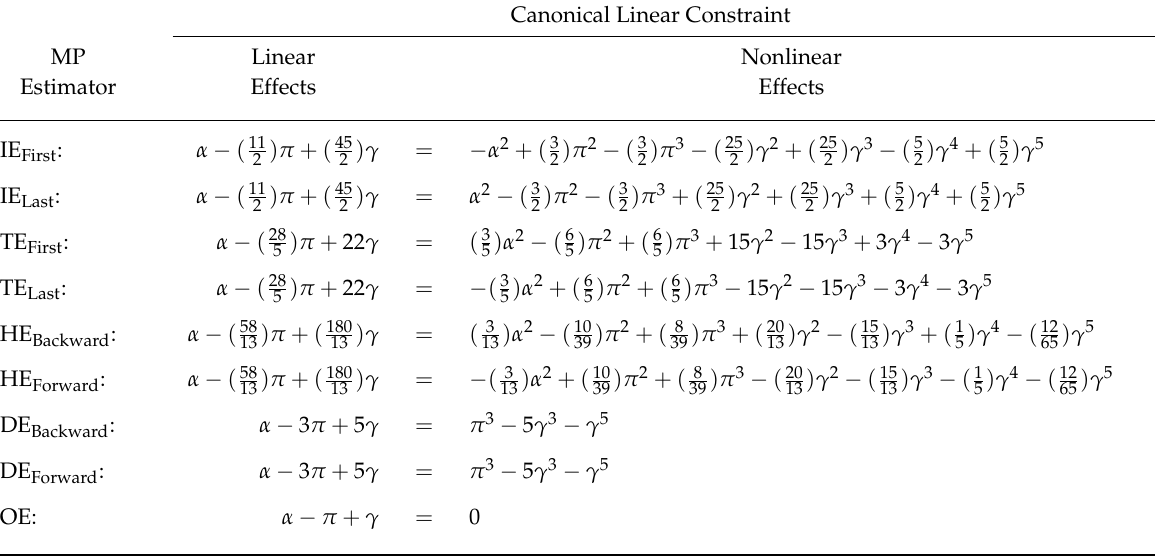
Table 4: Canonical form of linear constraints with I = 3 and J = 4